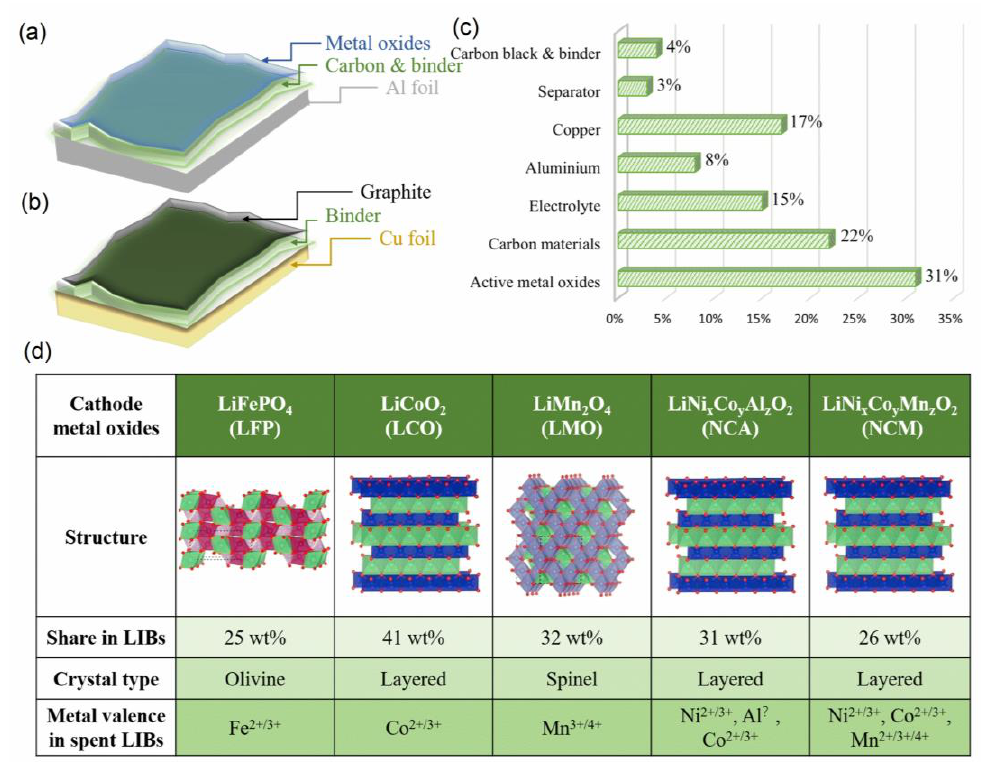
Figure 2. Composition of ( a ) cathode and ( b ) anode materials, ( c ) percentage of each components, and ( d ) comprehensive comparisons of cathode.